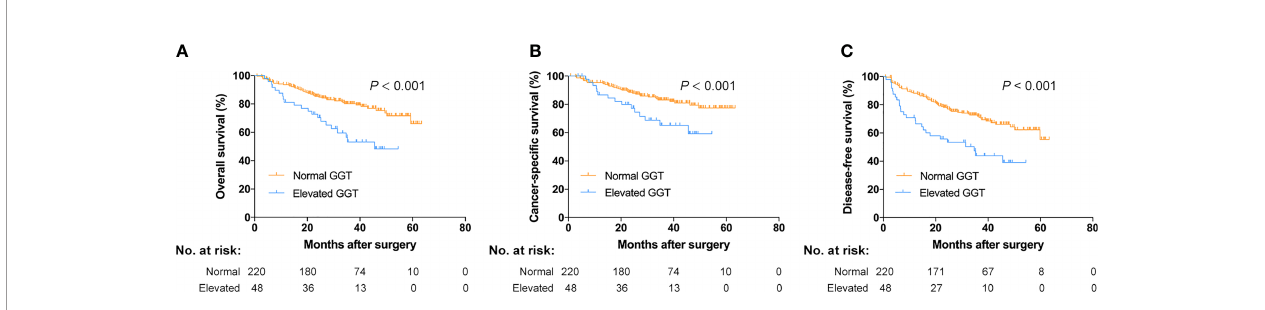
FIGURE 2 | Survival curves for normal and elevated GGT groups. (A) Overall survival; (B) cancer-speci fi c survival; (C)